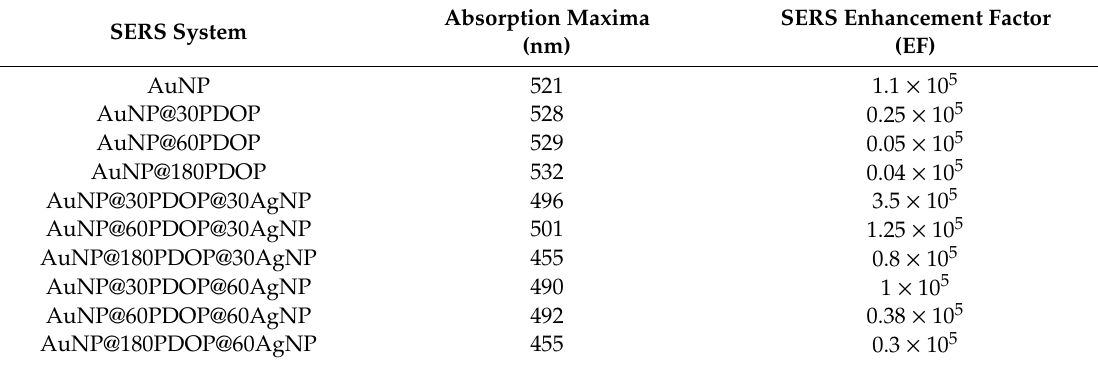
Figure 7. UV-vis absorption spectra of AuNP and AuNP@PDOP for different PDOP deposition times (numbers indicate deposition times in min). Table 1. Absorption maxima and calculated enhancement factor (EF) values for each surface-enhanced Raman spectroscopy (SERS) system.